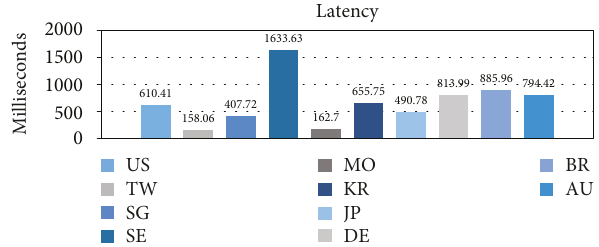
Figure 12: Geographical measurements of the emulation mode with time (latency).